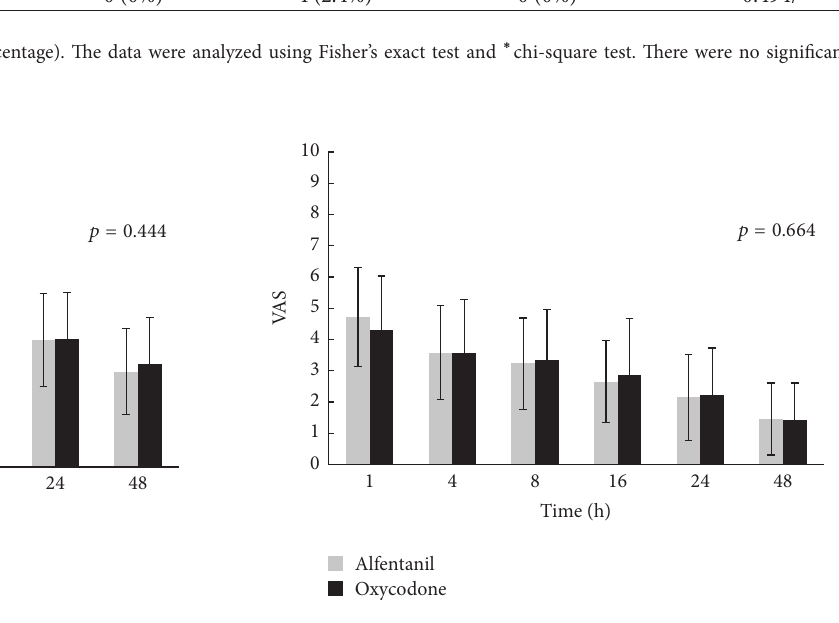
Figure 3: Visual analogue scale of pain at resting between 1 and 48 h after the operation. Means and standard deviation are shown. 𝑝 values were calculated by repeated-measures analysis of variance. There were no significant differences between two groups ( 𝑝 value < 0.05). VAS: visual analogue